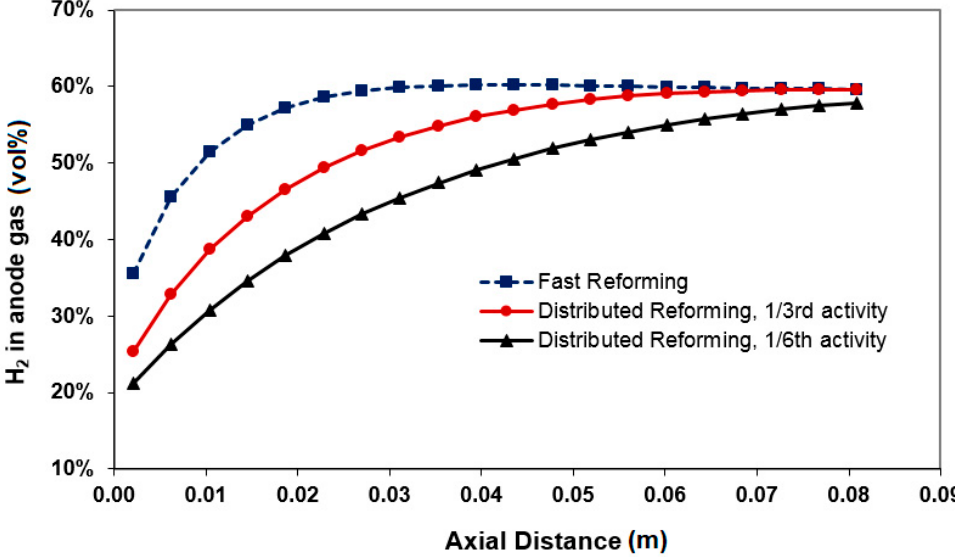
Figure 6. Open-circuit hydrogen concentration profiles for different reforming activity.